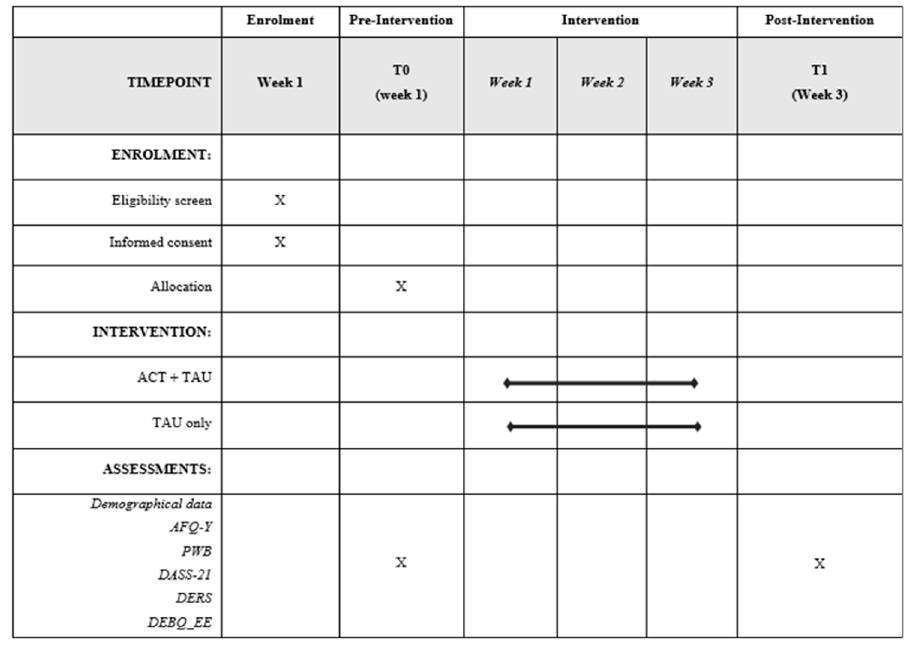
Figure 1. Spirit